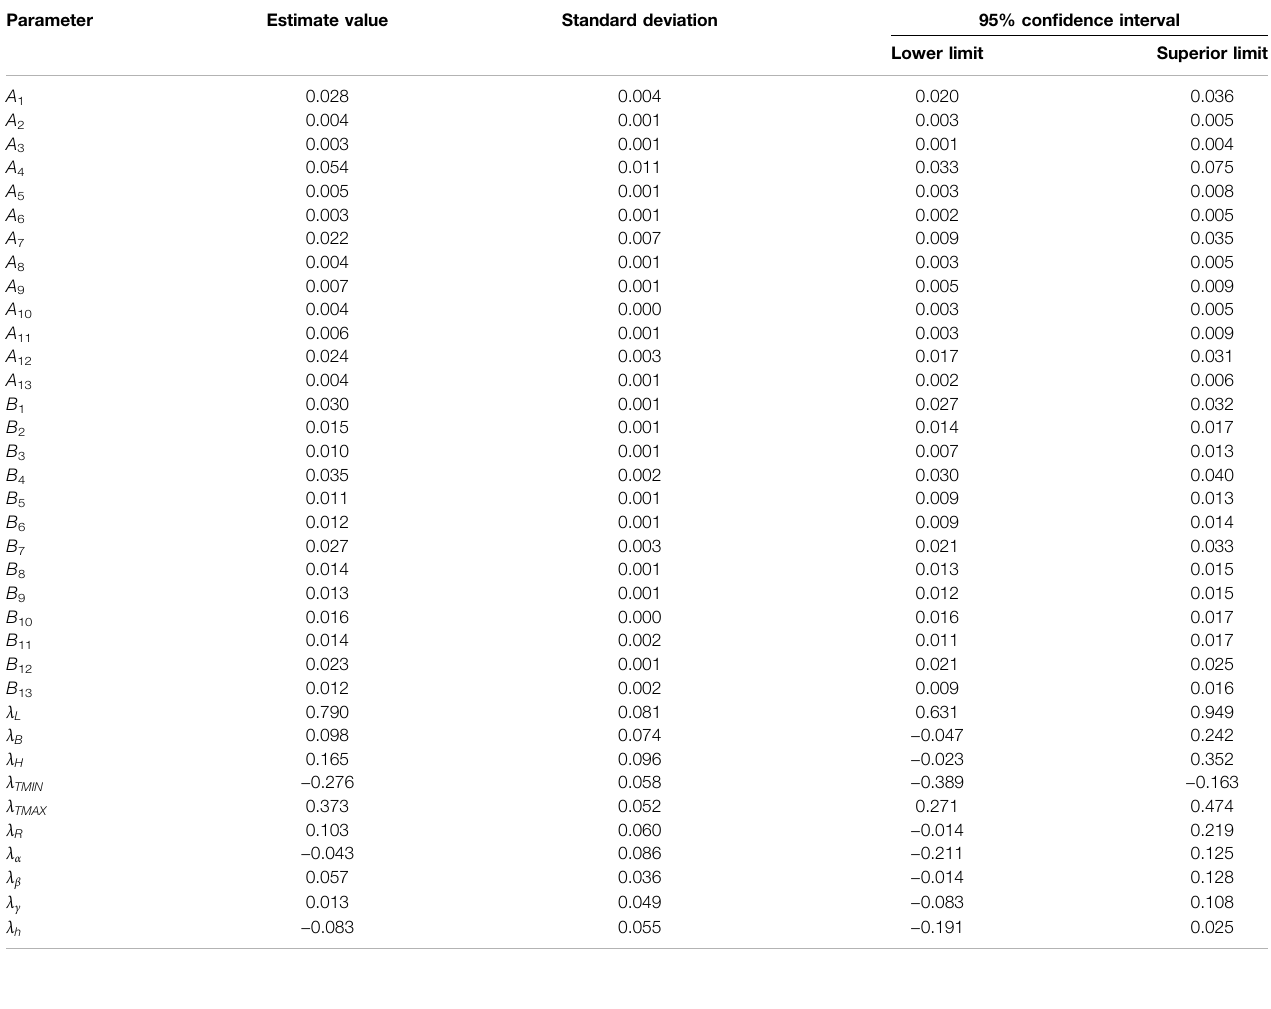
TABLE 3 | Fitting results of the major tree species groups ’ DBH growth predictions.